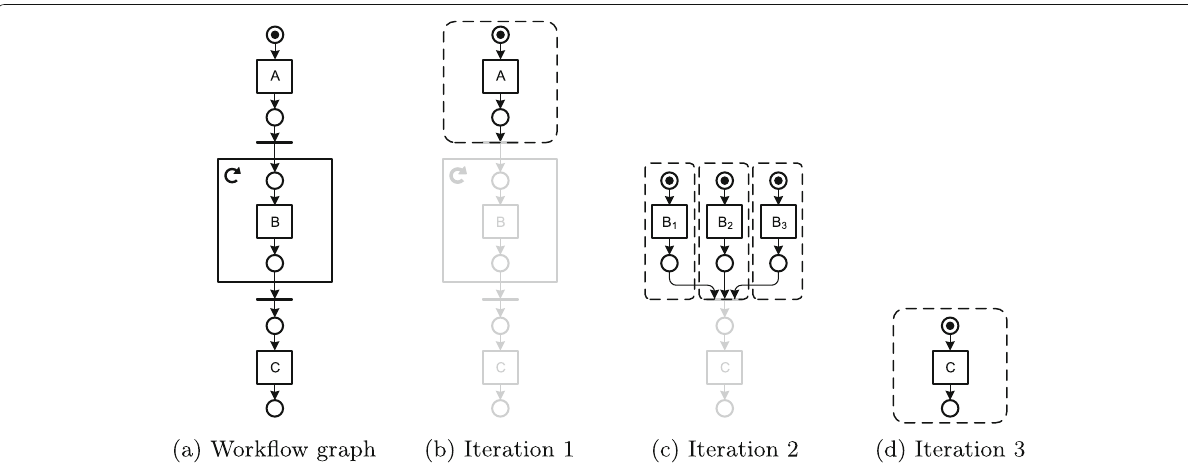
Fig. 9 Unrolling a for-each action. Example of how our algorithm splits a workflow graph with a for-each action into process chains (marked with dashed boxes) if action A produces three outputs